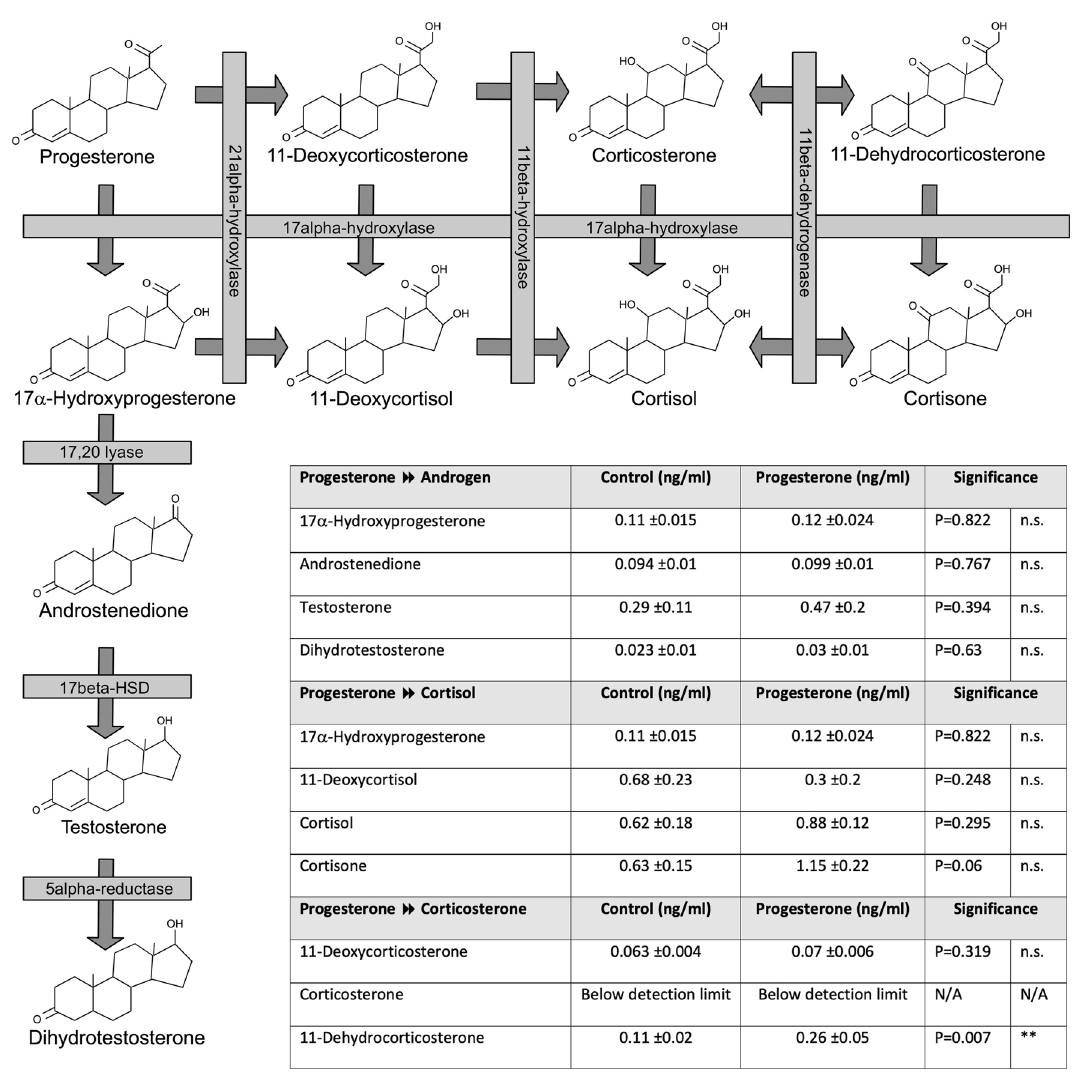
Figure 7. The effect of maternal progesterone administration on the metabolism of progesterone to other steroids in the male fetus at d75 gestation (C = 10, P = 7). Cartoon with chemical structures showing the enzyme pathways involved in the synthesis of androgens, cortisol and corticosterone. Maternal progesterone administration increases 11-dehydrocorticosterone concentrations in male fetuses. Unpaired, two-tailed Student’s t test was used for comparing means of two treatment groups with equal variances accepting P < 0.05 as significant (** P <